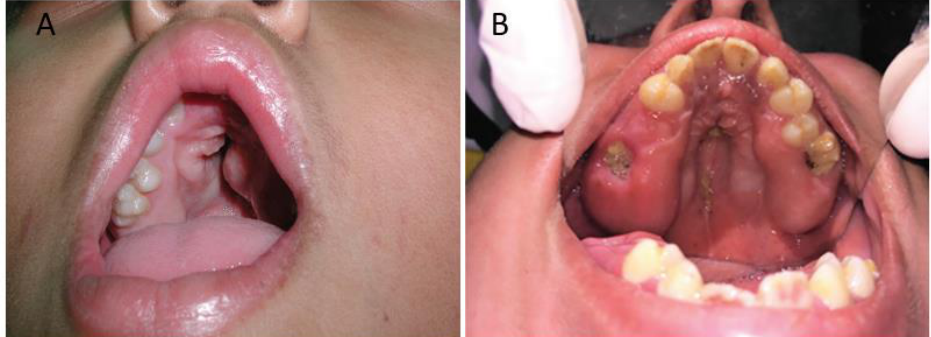
Figure 1. Cleft palate and high-arched palate in Apert syndrome. ( A ) Cleft palate in a patient with Apert syndrome (adapted from [48] and used with permission from Dermatology Online Journal: https://escholarship.org/uc/doj). ( B ) High-arched palate and gingival enlargement in a patient with Apert syndrome (adapted from [70]).